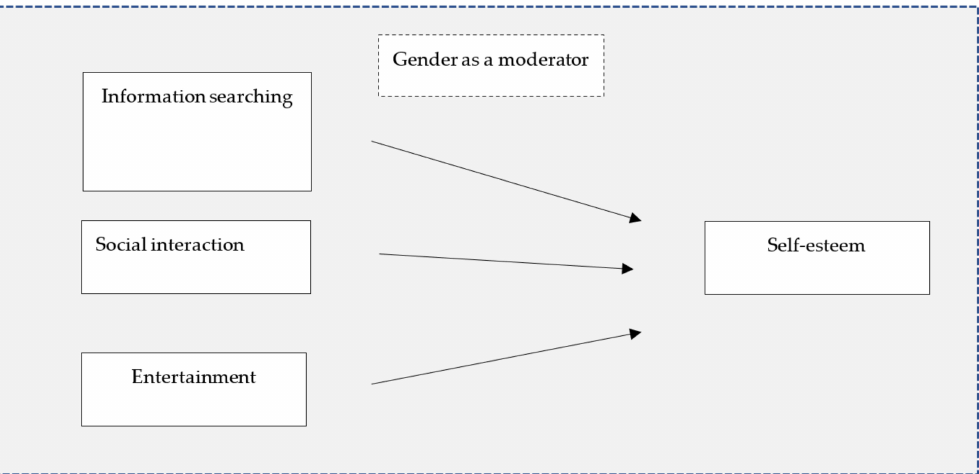
Figure 1. A hypothesized model of the present